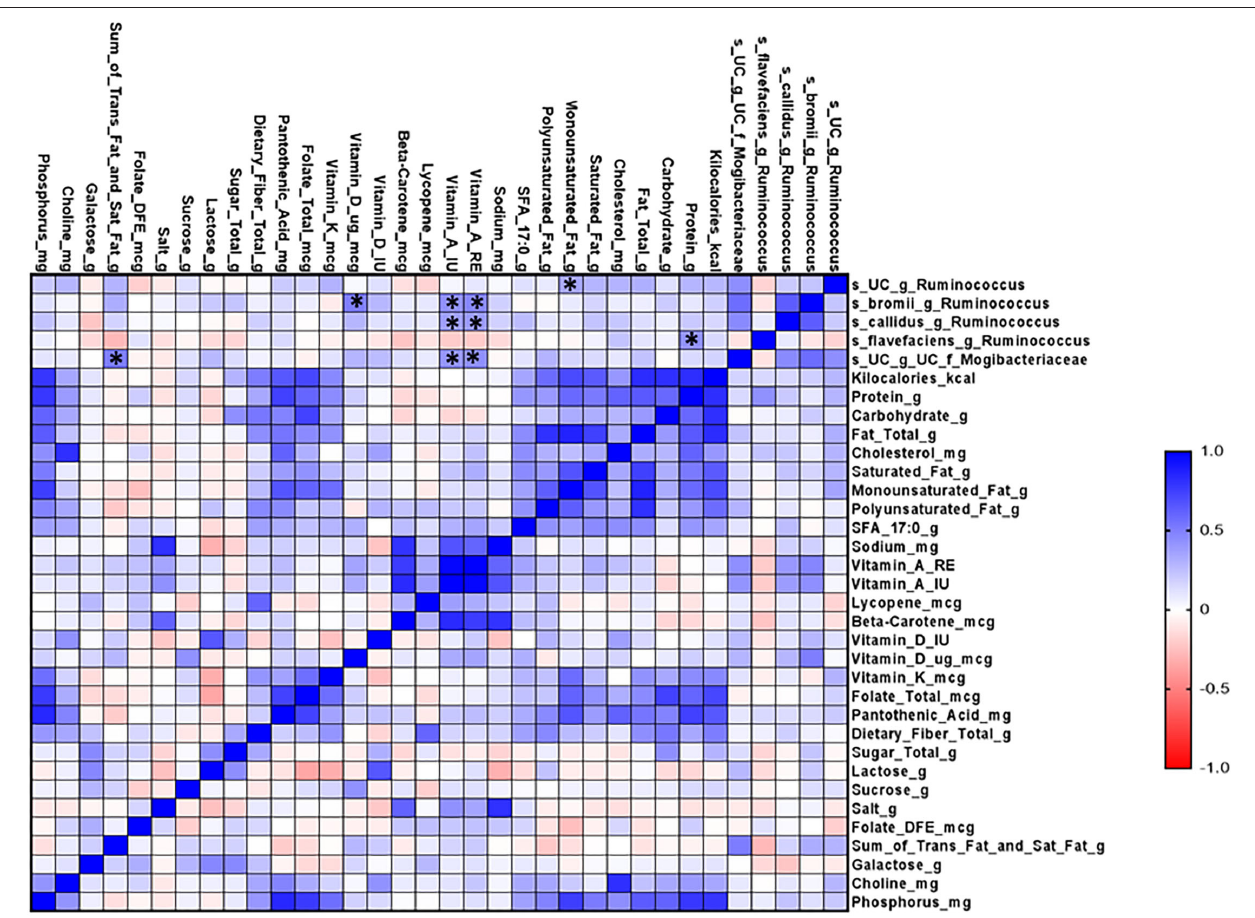
FIGURE 6 | Microbial correlation matrix analysis of diet and gut microbiome in the CVD no-risk and CVD risk groups. Correlation matrix analysis was performed using GraphPad Prism software. The red line indicates a negative correlation and the blue line indicates a positive correlation. CVD no-risk, N = 30; CVD risk N = 8. * p < 0.05 was considered statistically significant using Student’s t-